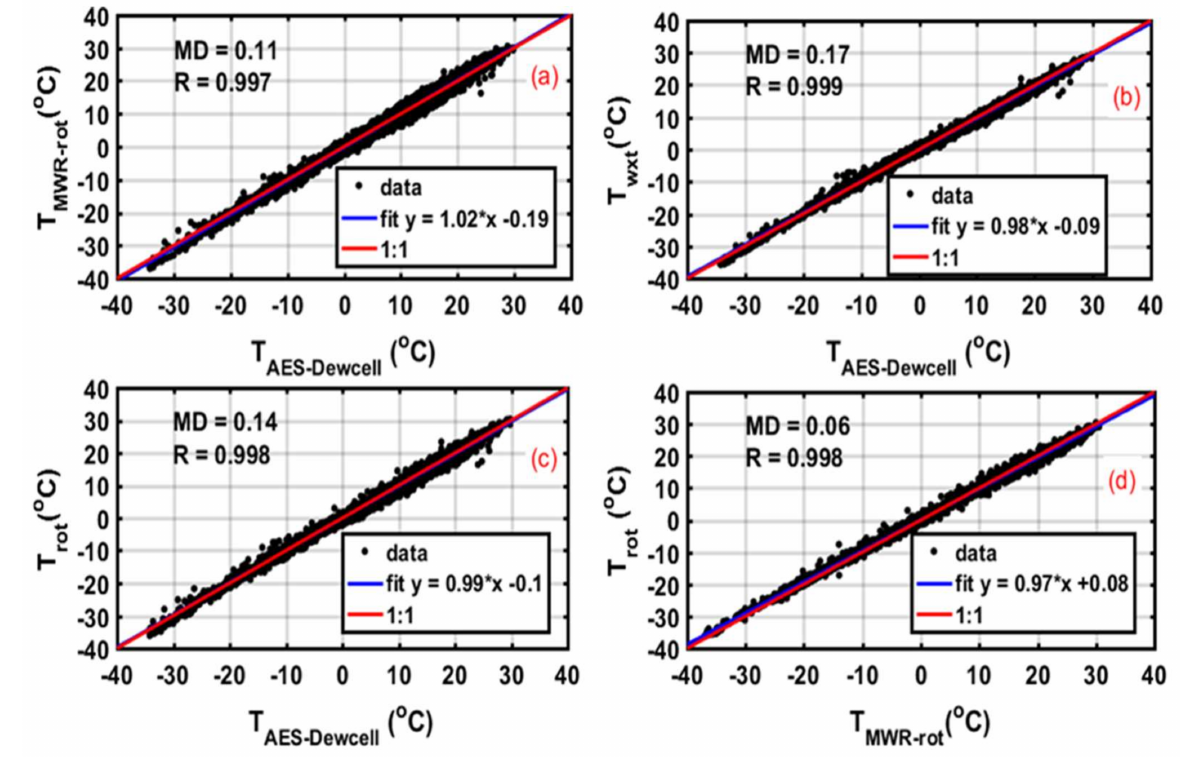
Figure 11. Similar to Figure 10, but for temperature in this